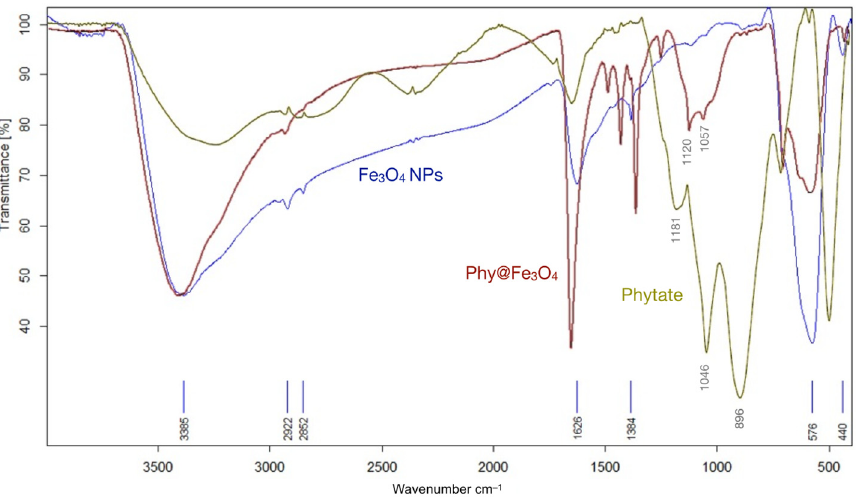
Figure 2. Infrared spectra (FT-IR) of different nanomaterials: Magnetite nanoparticles (Fe 3 O 4 NPs); Phytic acid sodium salt hydrate (Phytate); and magnetite nanoparticles covered with phytate groups (Phy@Fe 3 O 4 ).